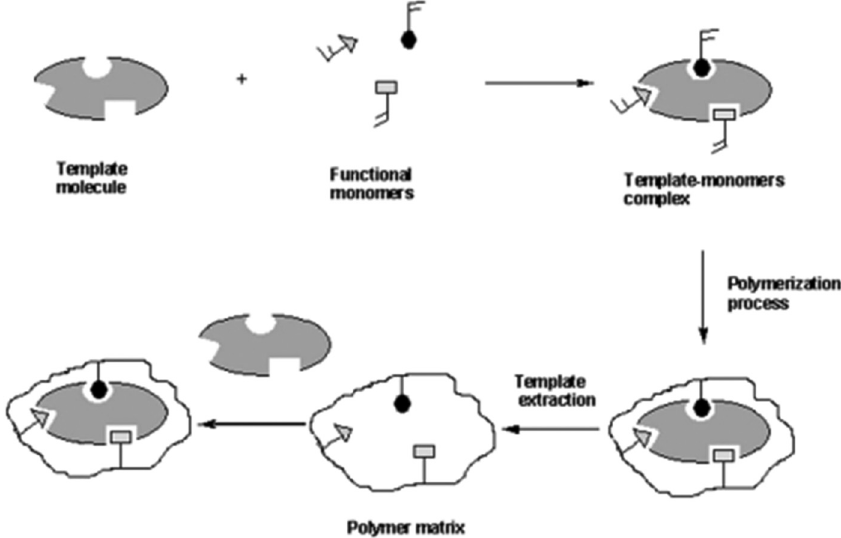
Figure 3: Molecular imprinting process; from ref. [ 130 ]